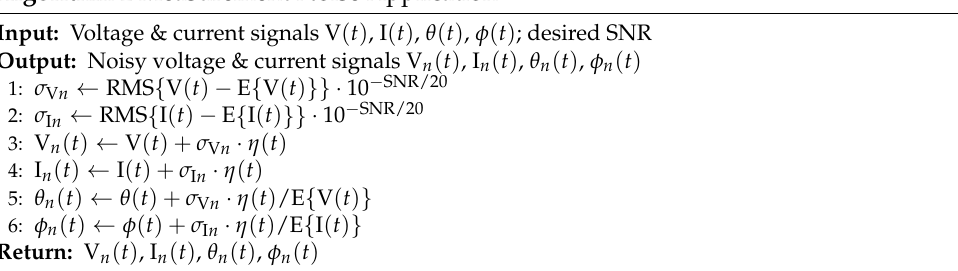
Algorithm 2 Measurement Noise